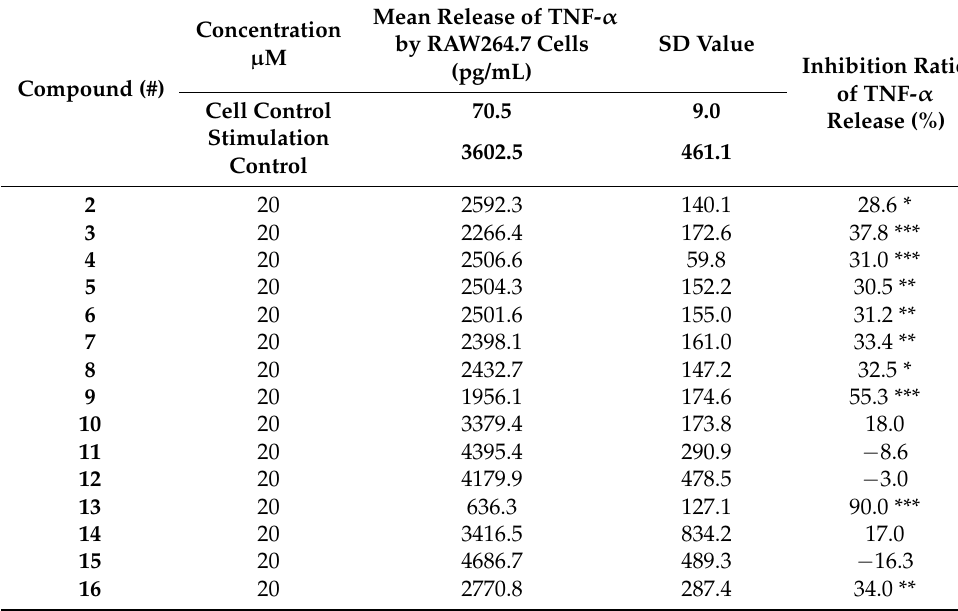
Table 1. Experiment results of anti-inflammatory activity screening of